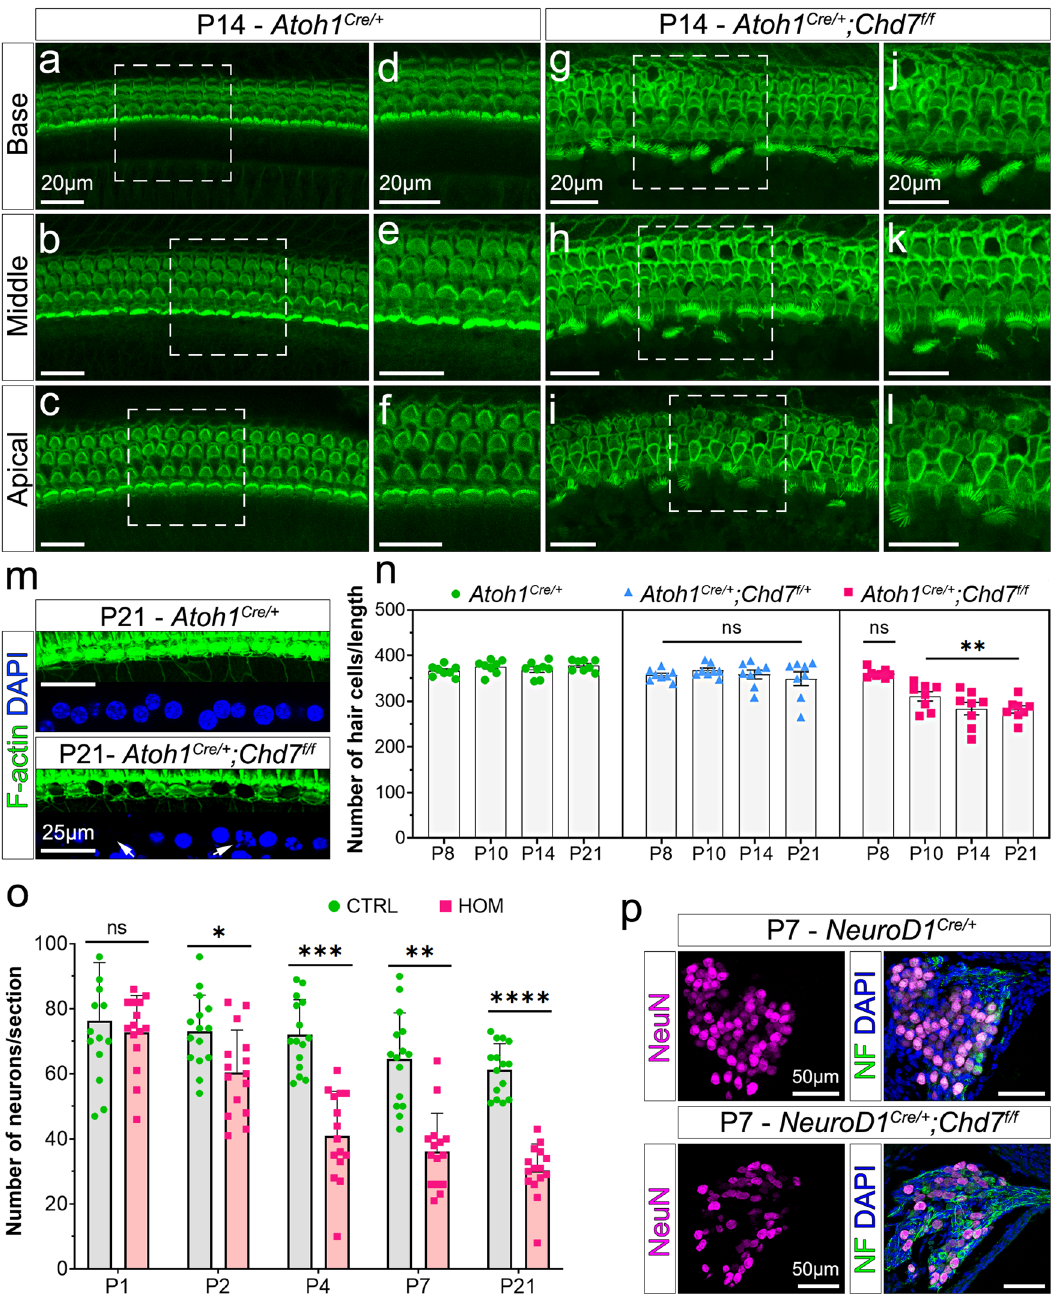
Fig. 3 Postnatal degeneration of hair cells and neurons in Chd7 mutants. a – l F-actin-stained hair cells in the cochlea of control ( a – f ) and Chd7 homozygous mutants ( g – l ) at P14. Dashed boxes in a – c and h , i indicate the zoomed regions shown in ( d – f ) and ( j – l ). Scale bars = 20 µ m. m Inner hair cells showing pyknotic, fragmented (arrow) and missing (arrow) nuclei in Chd7 mutants at P21. Scale bars = 25 µ m. n Average number of hair cells per 200 µ m regions in base, middle and apical turns of each cochlea per animal ( n = 8 per genotype; each animal is represented by one circle, triangle or square). Separate inner and outer hair cell quanti fi cation is provided in Fig. S2. Statistical signi fi cance was obtained by performing a nested one-way ANOVA and Dunnett ’ s multiple comparison test. ** P -value = 0.005. o Average number of neurons in the spiral ganglion per section at different postnatal stages in control (CTRL) and Chd7 homozygous mutants (HOM). Student ’ s t test, P -values: * = < 0.05, **< 0.005, *** = < 0.0005, **** = < 0.00005). p Spiral ganglia neurons stained with NeuN and neuro fi lament (NF) at P7 in control and mutant animals. Scale bars = 50 µ detection and ampli fi cation elicits oxidative stress in neurons and cells were intact along the entire length of the cochlea, as were hair cells that causes cell death unless tightly regulated 16,36 . We, untreated Atoh1 Cre/ + ;Chd7 f/f homozygous mutant hair cells therefore, tested the hypothesis that Chd7 mutant hair cells are ( n = 5/5 each; Fig. 7a, b). In contrast, gentamicin treatment of hypersensitive to oxidative stress by exploiting a cochlear explant Atoh1 Cre/ + ;Chd7 f/f mutant explants resulted in a reduction of hair cells by more than 50% across all regions of the cochlea ( n = 6/6; system in which oxidative stress can be induced by treatment with Fig. 7a, b). These fi ndings show that Chd7 mutant hair cells aminoglycosides 37 – 39 . When P6 control explants from Atoh1 Cre/ + ;mTmG mice were exposed to gentamicin for 5 h (100 µM), hair are hypersensitive to oxidative stress, causing degeneration in